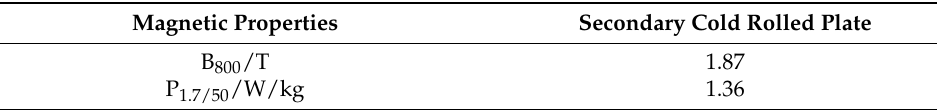
Table 1. Magnetic properties of final products.